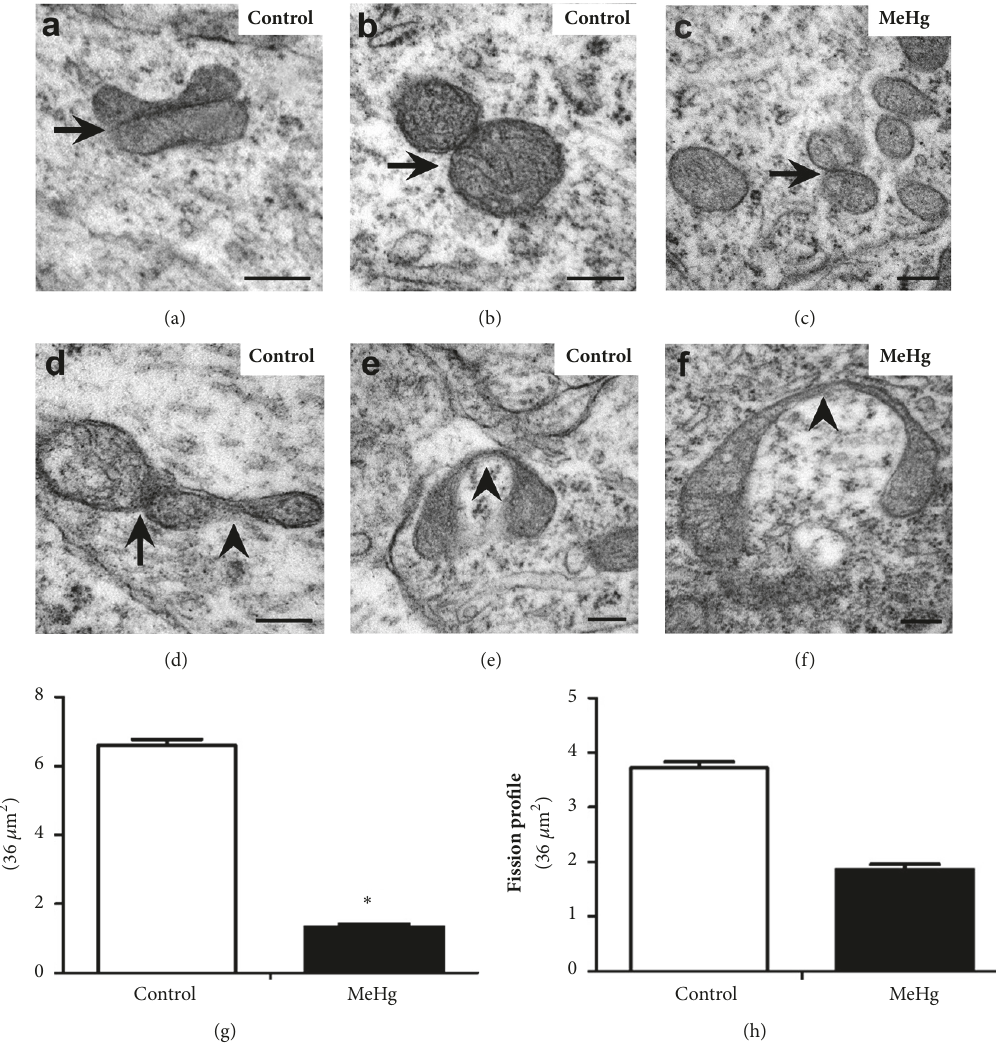
Figure 3: Effect of MeHg on mitochondrial fusion and fission profiles in spinal cord cells of E10 embryos . Electron micrograph of the mantle layer in control and MeHg-treated embryos. The graphs show the number of the fusion (g) and fission (h) mitochondrial profiles in both analyzed groups. Mitochondrial fusion (black arrow) and fission (arrowhead). ∗ Indicates P < 0.05. Scale bars: (a–f) 200 𝜂